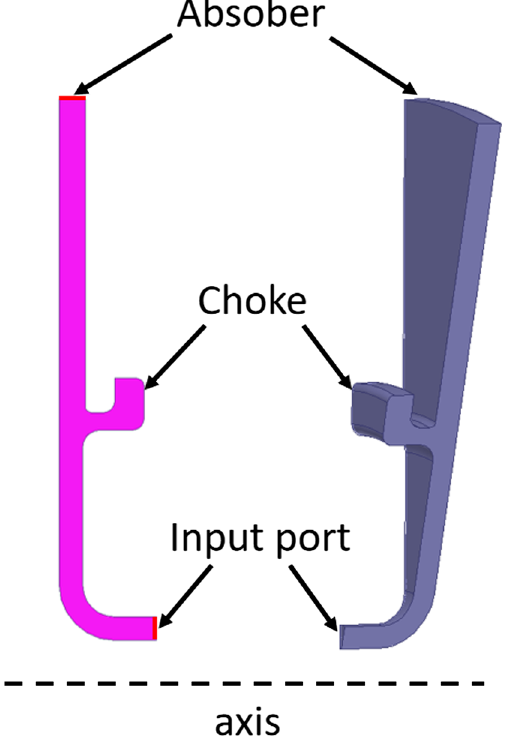
FIG. 2. Structures to test the reflection at choke.